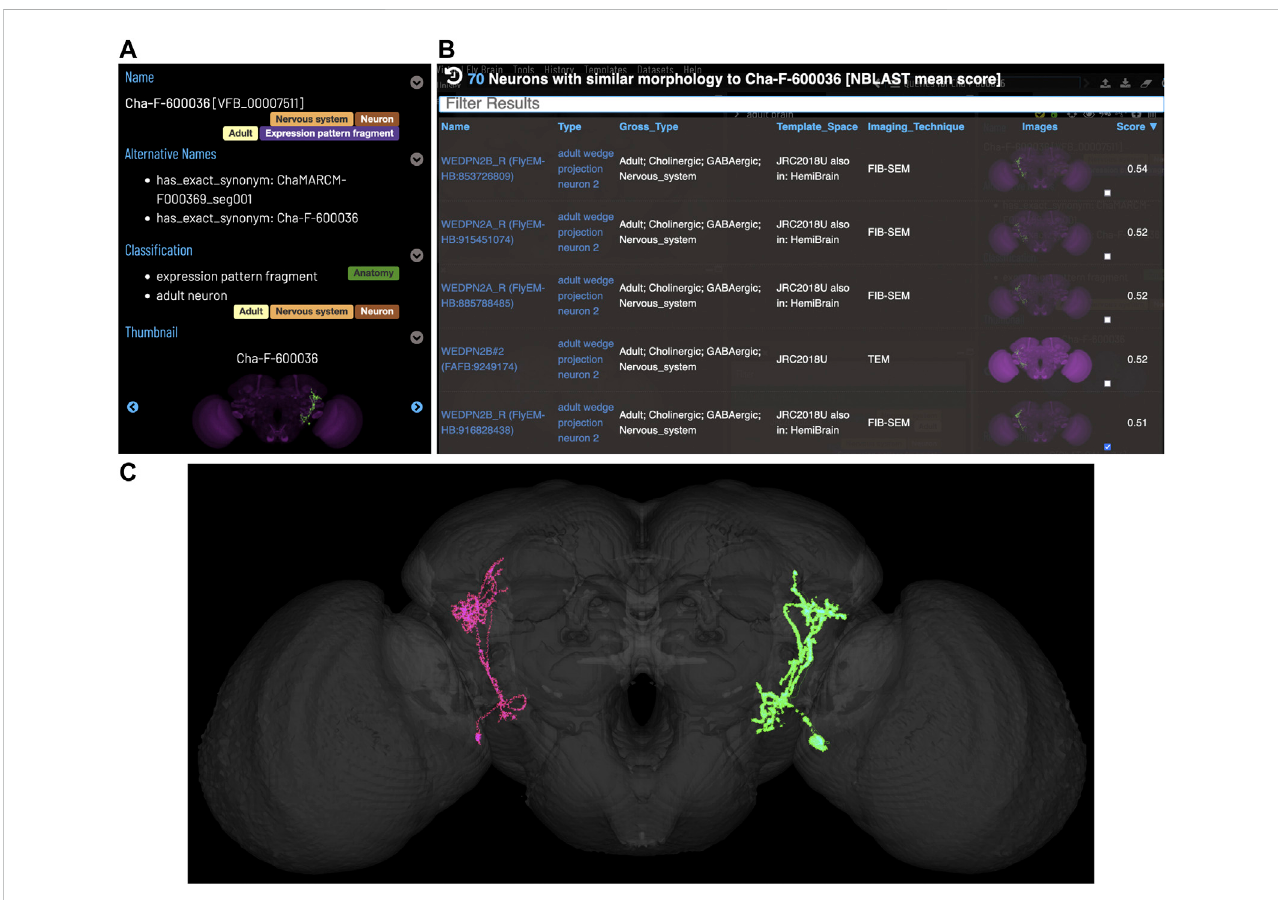
FIGURE 5 TypingneuronsusingNBLAST . (A) TermIinfoforaneuronfromFlyCircuit(Chiangetal.,2010)withnocuratedtypeotherthan “ neuron ” . (B) NBLASTquery results for neurons similar morphology to the untyped query neuron. The top fi ve results are all typed as “ adult wedge projection neuron 2 ” . (C) image comparing the morphology of the query FlyCircuit neuron [ “ Cha-F-600036 (VFB_00007511) ” in green] and the ‘ adult wedge projection neuron 2 ’ “ WEDPN2B_R (FlyEM-HB:916828438) [VFB_jrchk7yi]" WEDPN2B_R in